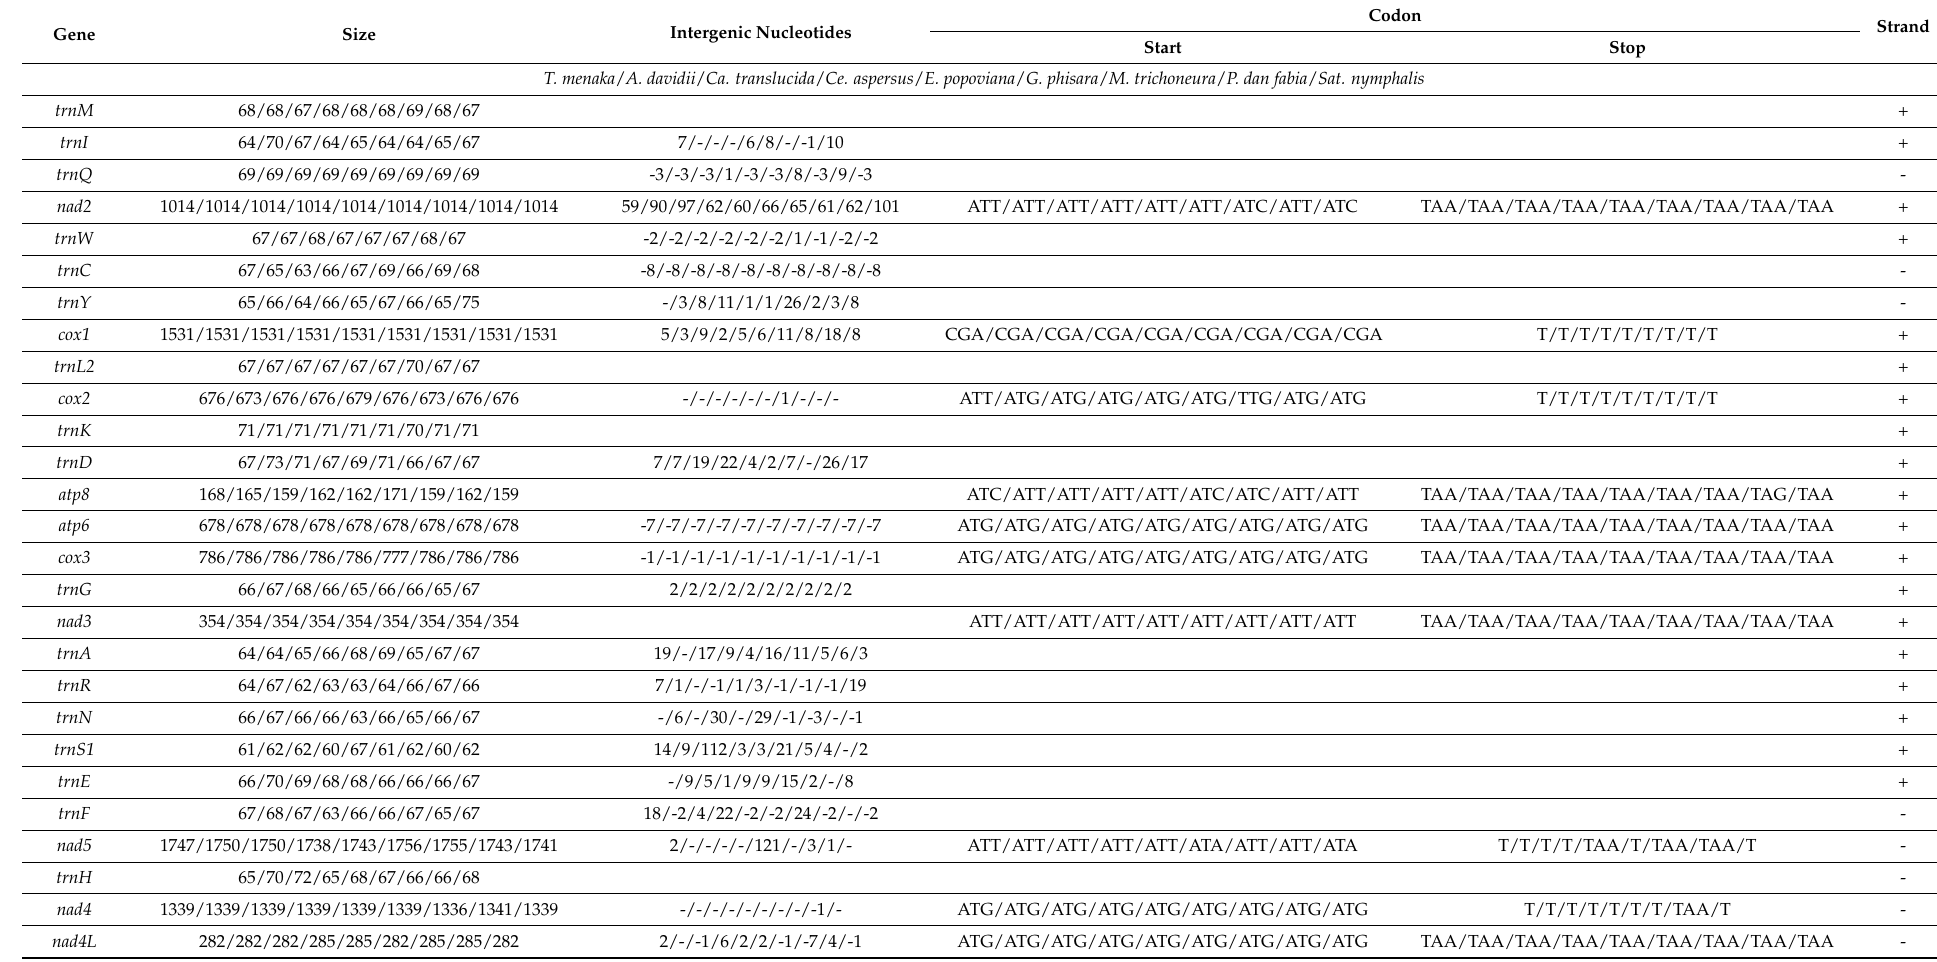
Table 6. Mitogenomic organization of the nine